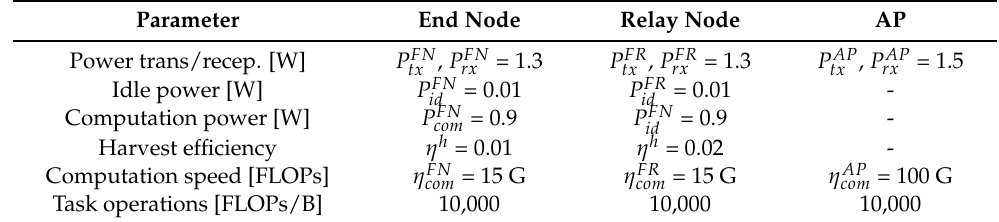
Table 2. Simulation